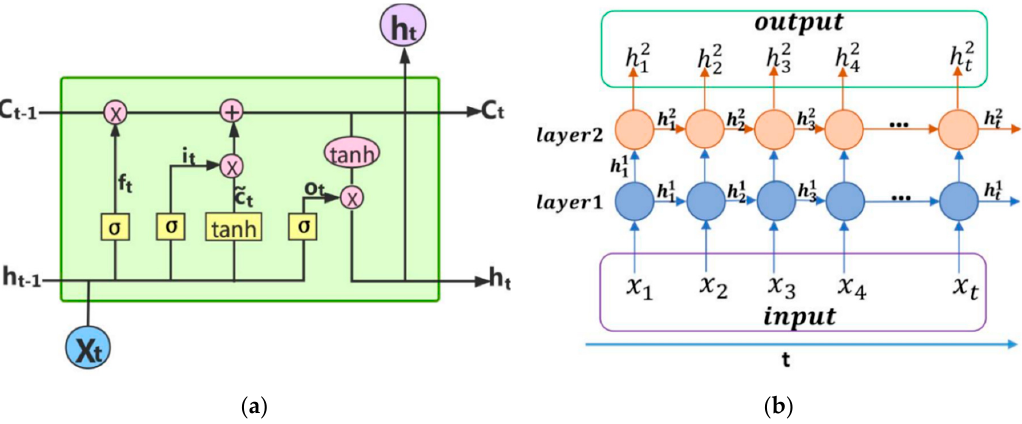
Figure 2. Internal and external structure of LSTM ( a ) cell and ( b ) network layers.